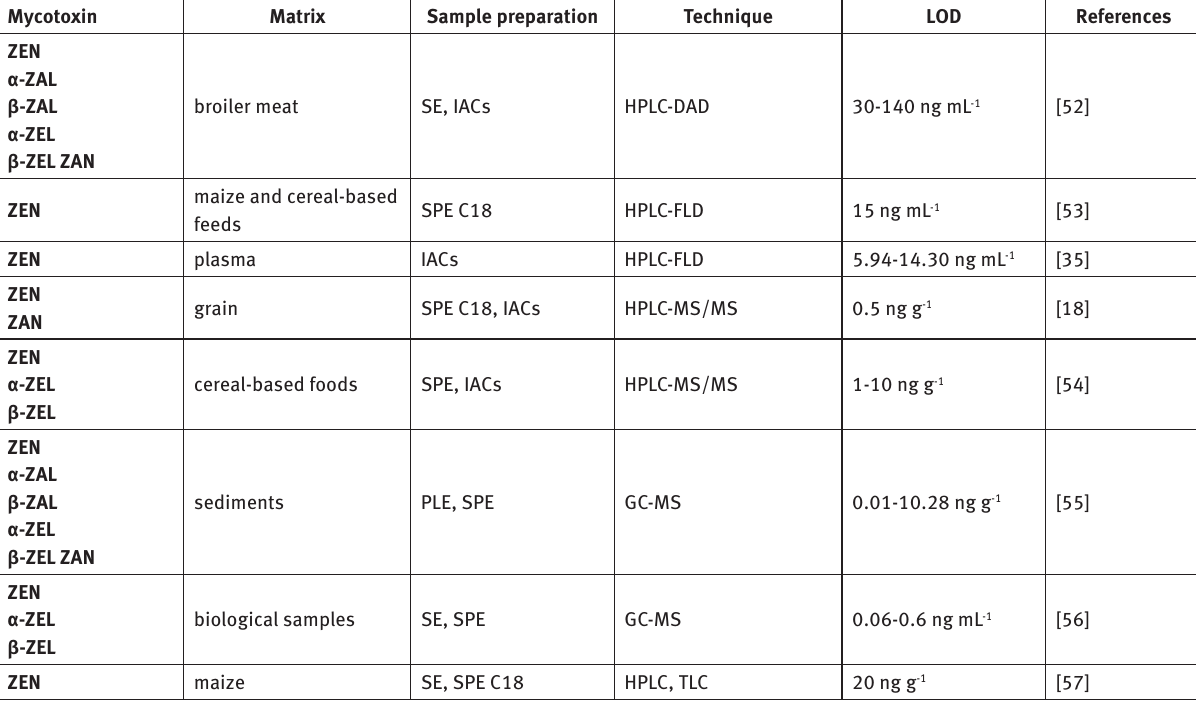
Table 2: Various analytical techniques for detecting ZEN and its metabolites in different matrices Mycotoxin Matrix